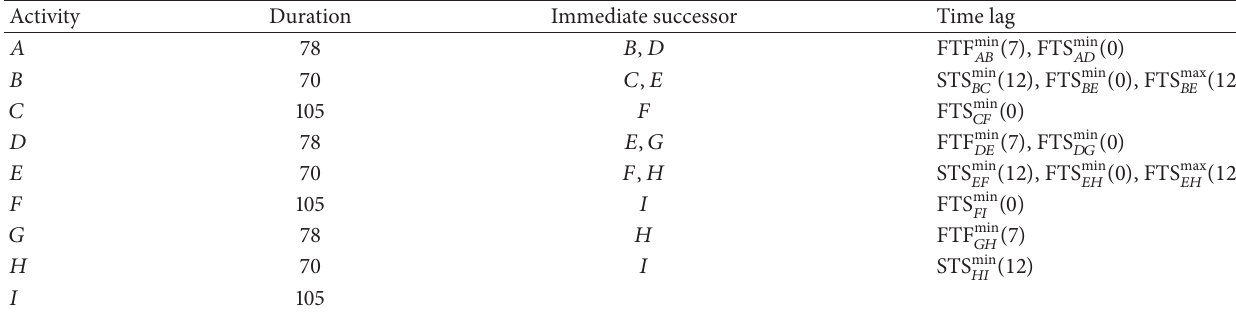
Table 1: Precedence relations between